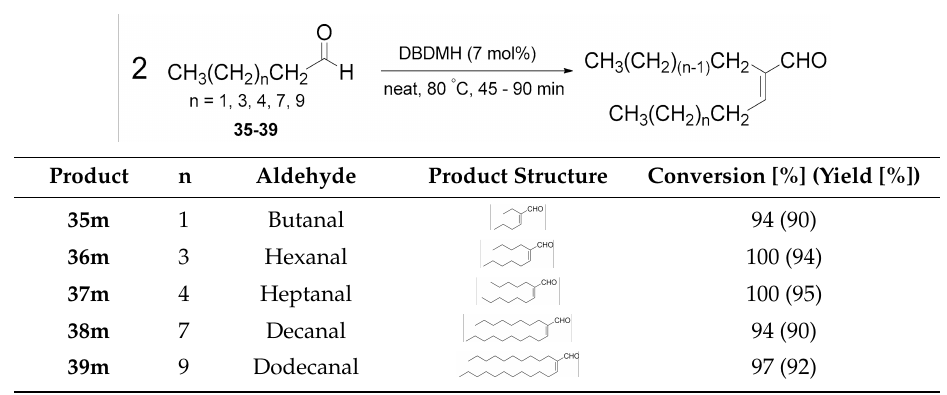
Table 9. E ff ect of chain elongation on aldol condensation e ffi ciency 1,2,3